Question: Which visualization type does this figure use?
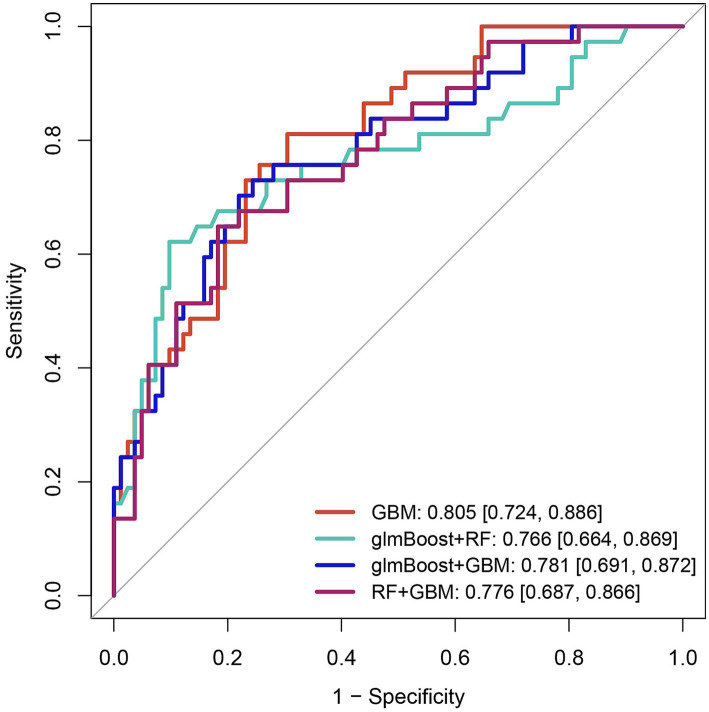
Answer: line